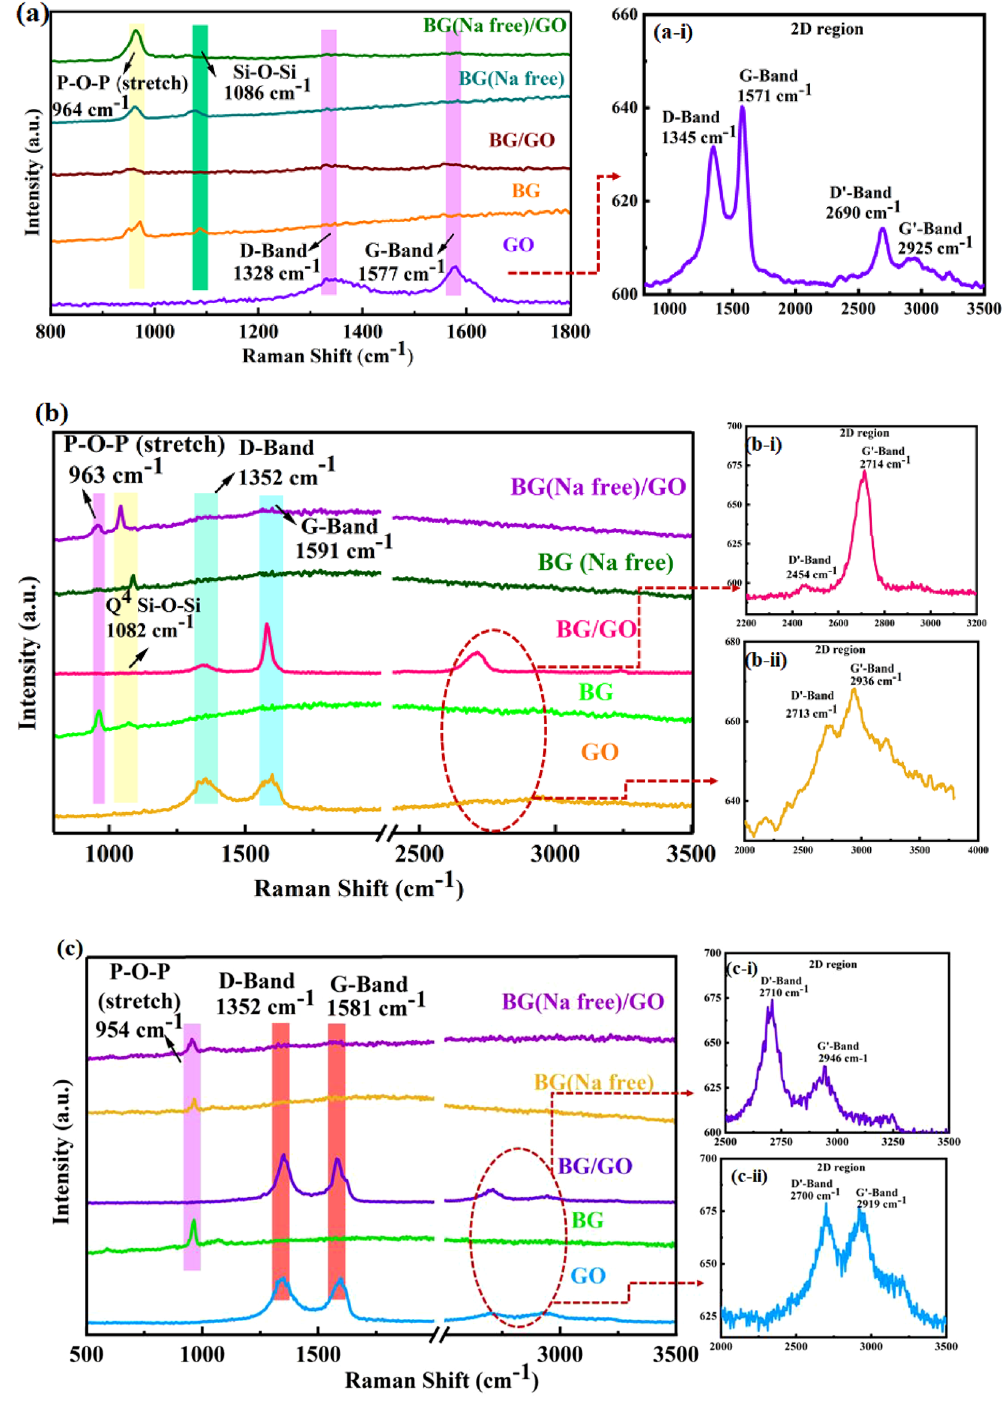
Figure 11. Raman spectra of BG, BG (Na-free), GO and BG/GO, BG (Na-free)/GO nanocomposites after mineralization; ( a ) 1st day; ( a-i ) 2D-region of GO, ( b ) 14th day; ( b-i,b-ii ) 2D-region of BG/GO and GO, ( c ) 28th day; ( c-i,c-ii ) 2D-region of BG/GO and